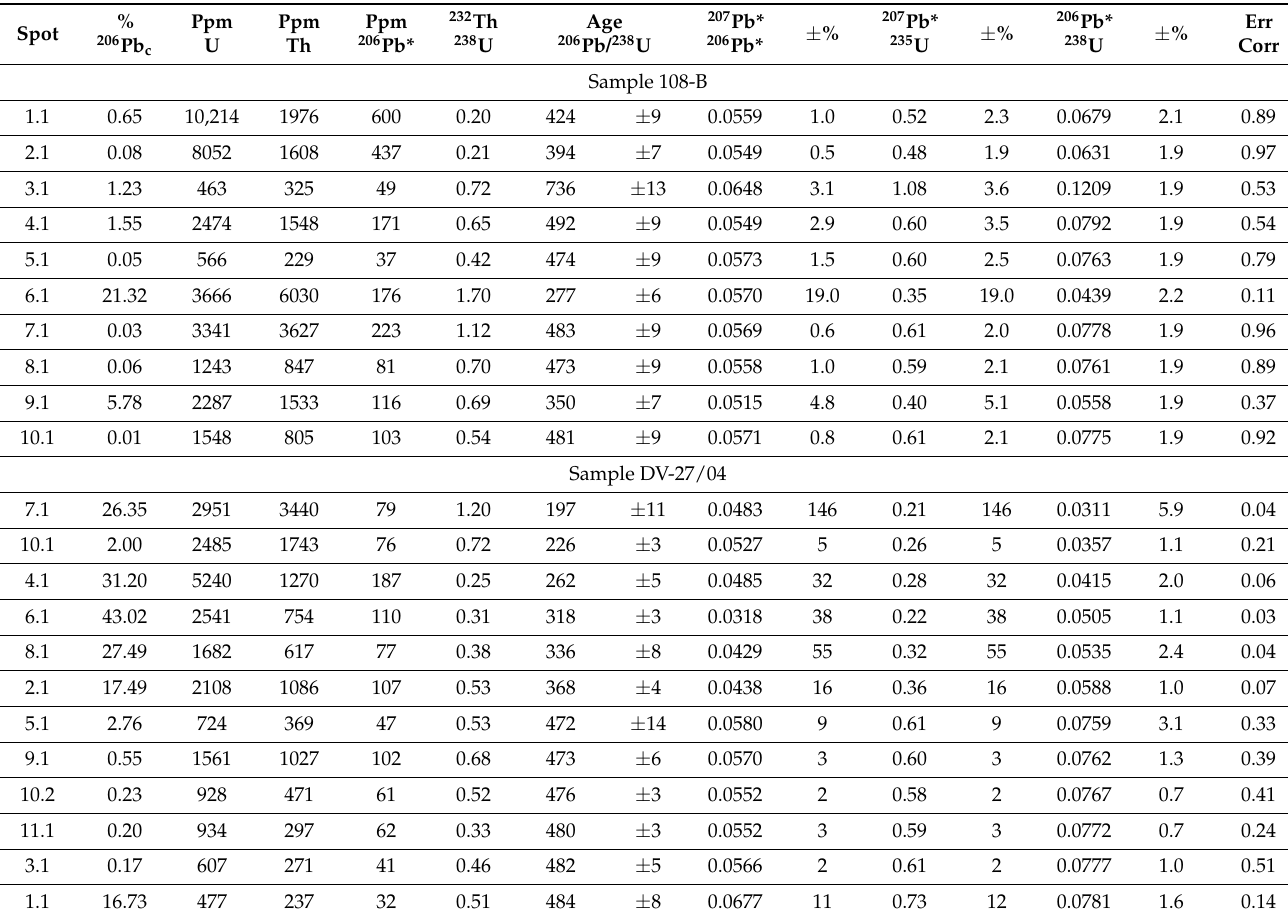
Table 1. U–Pb SIMS SHRIMP IIe isotope data of zircon from the leucogranite 108-B and the biotite granite